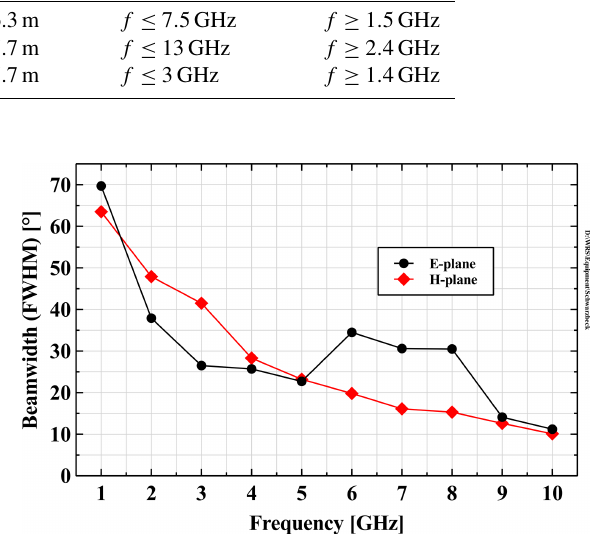
Figure B3. Beamwidths of dual-polarization antennas. Shown is the full width at half maximum (FWHM) of the measured radiation intensity patterns in the two principal planes (Schwarzbeck Mess- Elektronic OHG,